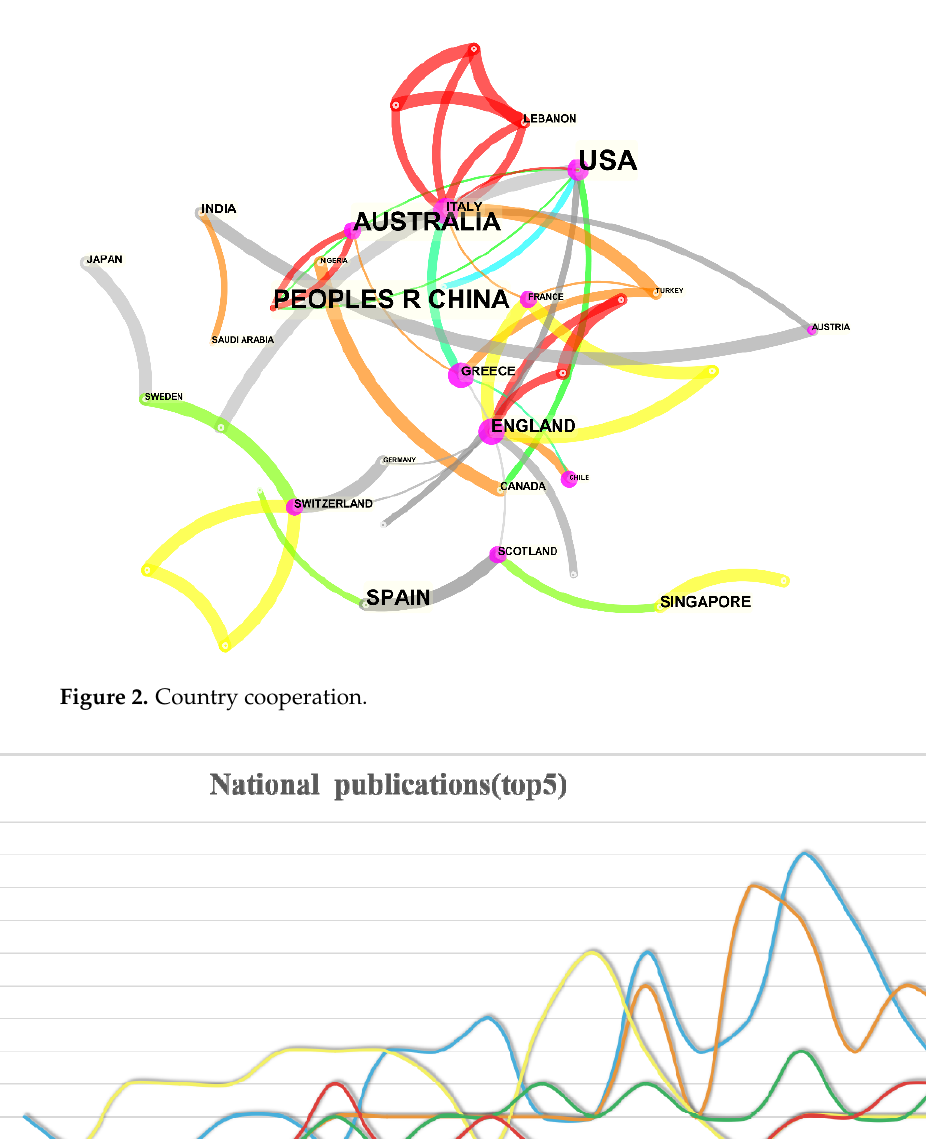
Figure 2. Country cooperation. Table 1. Statistics of national cooperative publishing (Top 10).